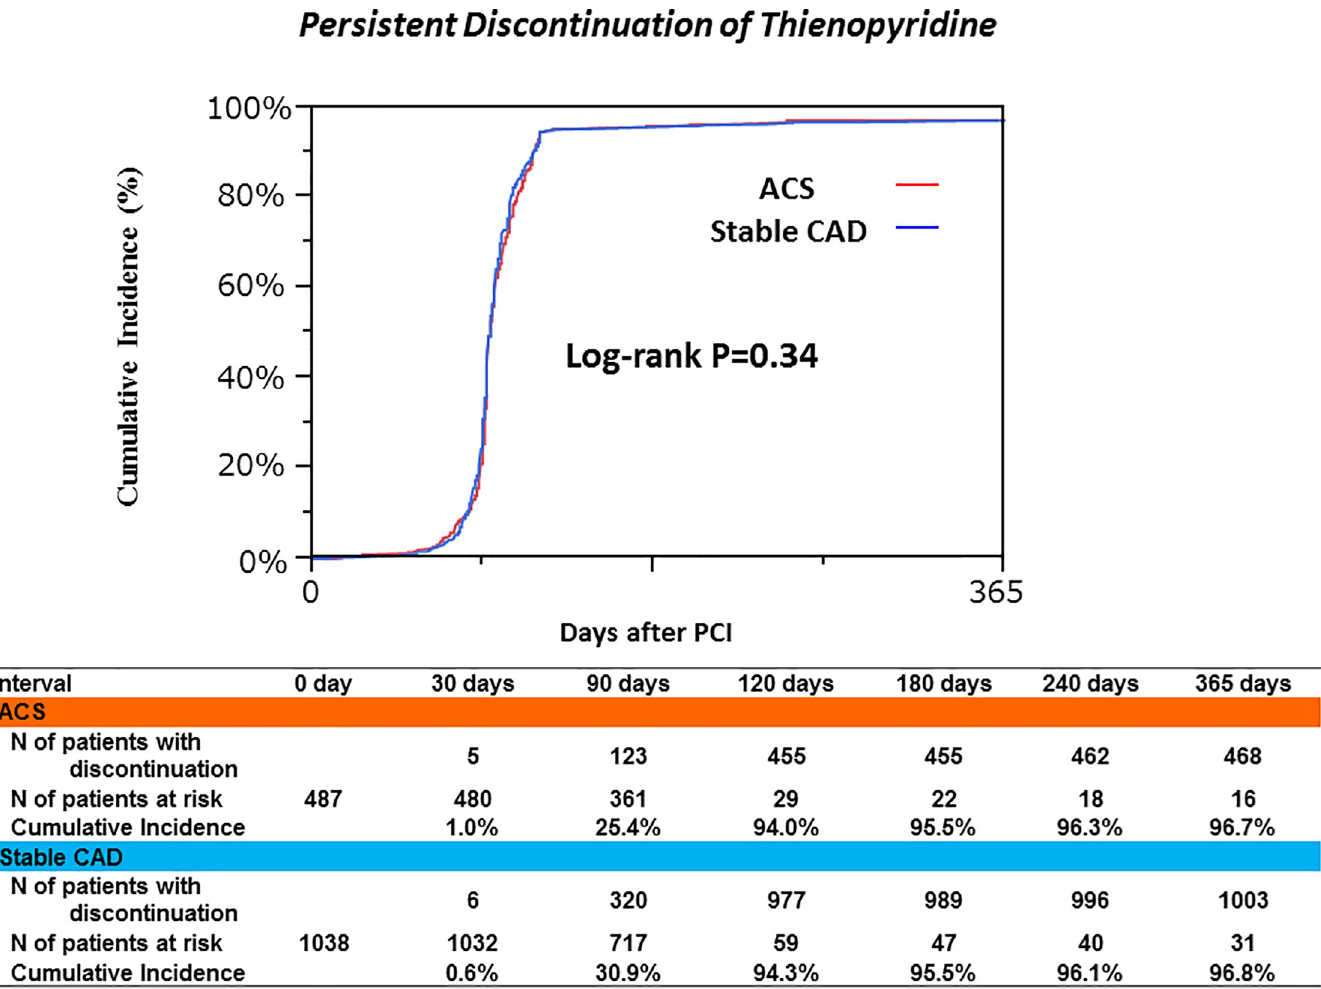
Fig 2. Cumulative incidence of persistent discontinuation of thienopyridine. ACS, acute coronary syndrome; CAD, coronary artery disease; PCI, percutaneous coronary intervention.